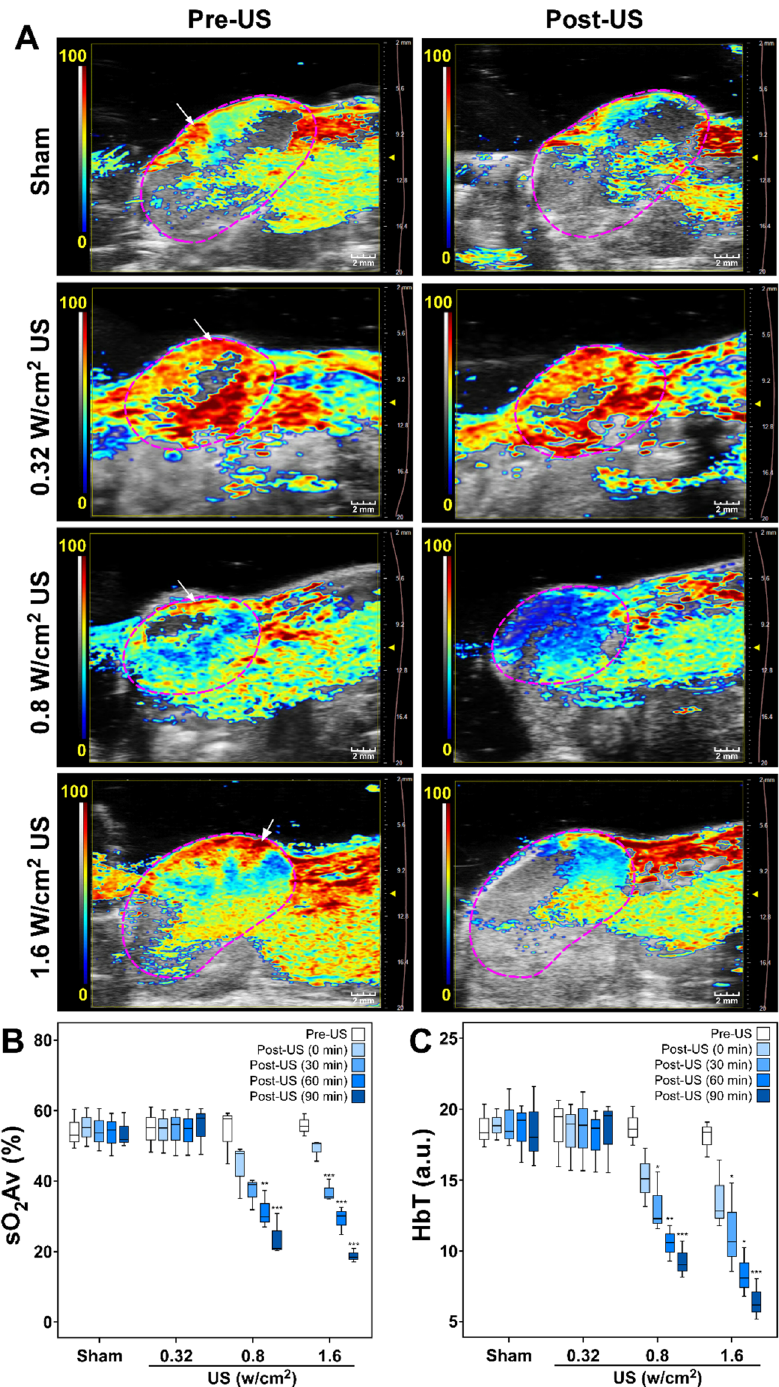
Figure 1. Photoacoustic assessment of HCC tumor oxygenation before and after US treatment. Three different US treatment groups with I SATA of 0.32 W/cm 2 (peak pressure = 0.23 MPa), 0.8 W/cm 2 (peak pressure = 0.36 MPa), and 1.6 W/cm 2 (peak pressure = 0.23 MPa) were investigated and compared. ( A ) Representative two-dimensional PA images of tumors displaying blood oxygen saturation maps with co-registered grayscale B-mode images acquired before (Pre-US) and 90 min after (Post-US) ultrasound therapy. Oxygenation level ranges from 0% (dark blue) to the 100% (dark red). White arrows show high PA signal in the periphery of the tumor. The boxplots display the minimum, first quartile, median, third quartile, and the maximum of the oxygenation measurements for ( B ) sO 2 average (sO 2 Av) and ( C ) total hemoglobin (HbT) in the whole tumor volume. Mean values of sO 2 Av or HbT in the whole tumor volume for the sham, 0.32, 0.8, and 1.6 W/cm 2 US treatment groups were calculated and compared, Pre-US versus Post-US. *, **, and *** represent statistical significance of p ≤ 0.05, p ≤ 0.01, and p ≤ 0.001, respectively. Scale bar 2